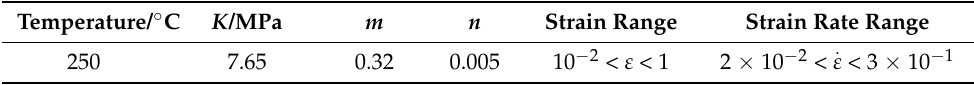
Table 1. Mechanical properties of used